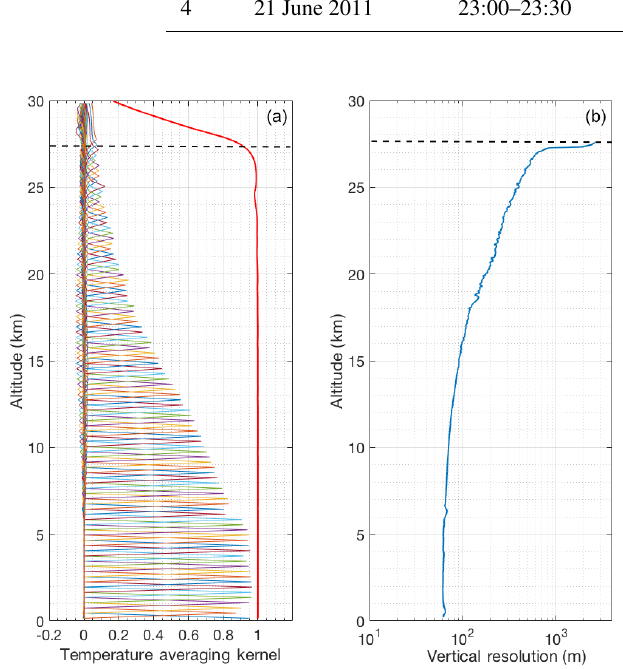
Figure 3. Averaging kernels (a) and vertical resolution (b) for tem- perature retrievals from the clear nighttime RALMO measurements on 9 September 2011. The area of the averaging kernels at each height, the response function, is the solid red line. The horizontal dashed line shows the height below which the retrieval is due pri- marily to the measurement and not the a priori temperature profile. For clarity averaging kernels for every fifth height bin of the re- trieval grid are shown.